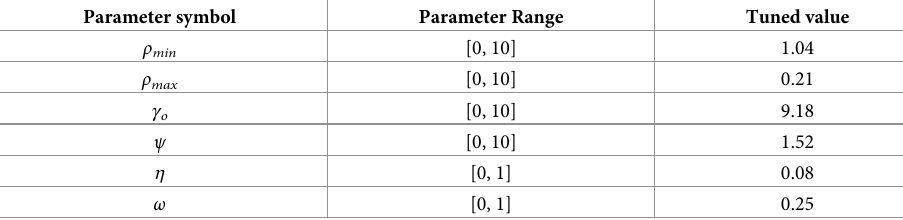
Table 3. Parameter selection of the HSF for the ACWF-STR